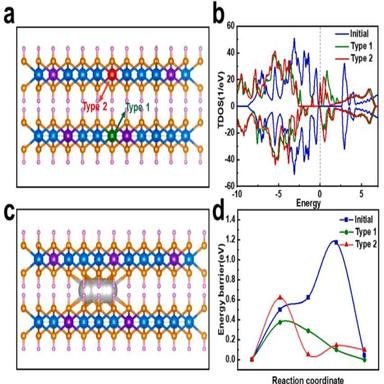
The crystal structure models and two different types of Al doping sites (a), calculated density of states (b), diffusion path of potassium ion in an initial crystal structure without Al doping (c), barrier energy, and diffusion path of potassium ion under a different type of Al sites (d). Here, blue, purple, orange, pink, and gray are Ni, Co, O, H, and K atoms, respectively. (For interpretation of the references to color in this figure legend, the reader is referred to the web version of this article.)